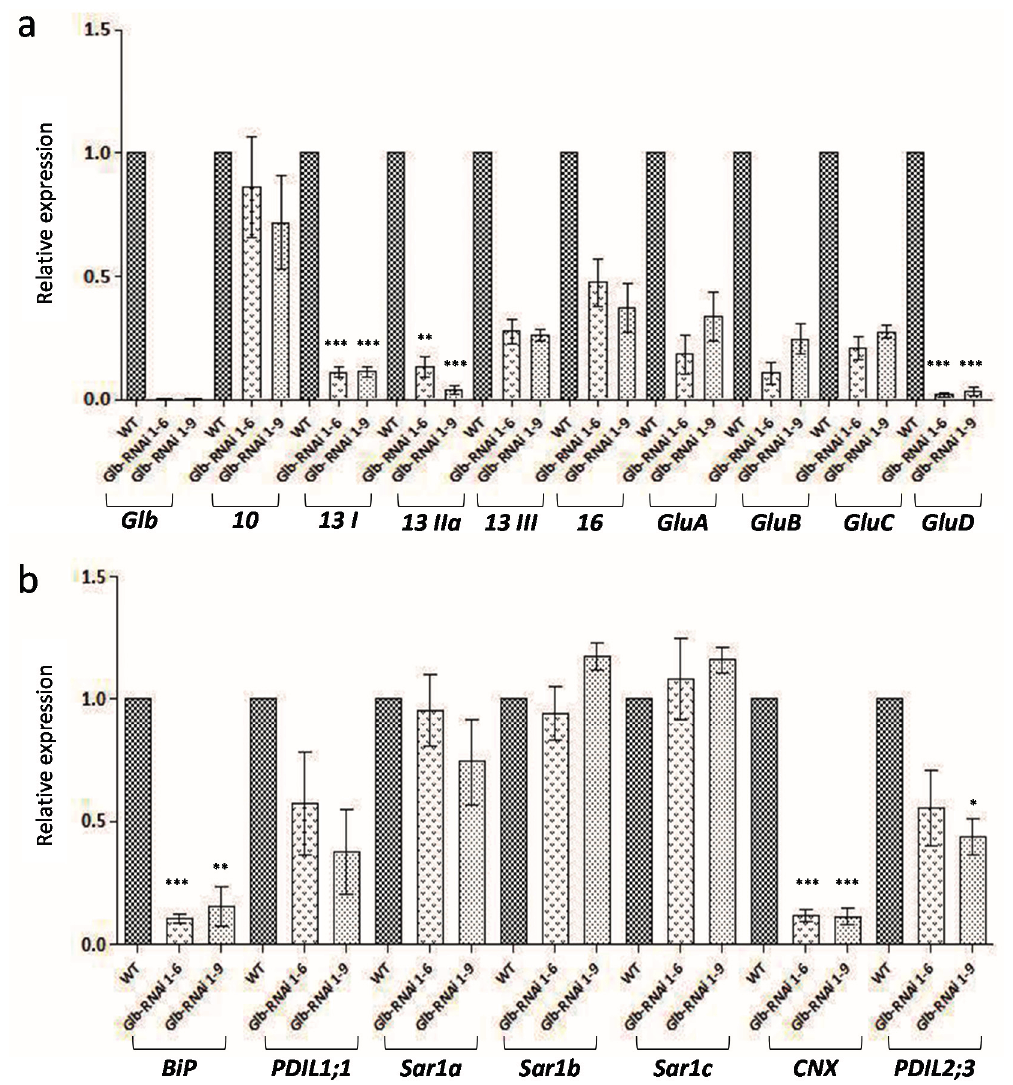
Figure 2. Quantitative real-time reverse transcription (RT)-PCR analysis of Glb-RNAi transformants. ( a ) Transcription levels of SSP genes; and ( b ) genes related to endoplasmic reticulum (ER)-localized chaperone proteins were analyzed in the immature seeds of wild type (WT) and Glb-RNAi 1–6 and 1–9 lines. Data are the means ± SD of three biological replicates. Statistically significant differences between the WT and RNAi lines are indicated by asterisks (* p < 0.05; ** p < 0.01; *** p < 0.001; t -test). Ubiquitin was used as the internal control gene in this analysis. Glb , globulin; 10 , prolamin 10 kDa; 13 I , prolamin 13 kDa-I; 13 IIa , prolamin 13 kDa-IIa; 13 III , prolamin 13 kDa-III; 16 , prolamin 16 kDa; GluA , glutelin A; GluB , glutelin B; GluC , glutelin C; GluD , glutelin D; BiP , binding protein; PDIL , protein disulfide isomerase like; Sar1 a – c , Ras related GTPase 1 homologues a, b and c; and CNX , calnexin. The primers used for RT-PCRs are informed in Table